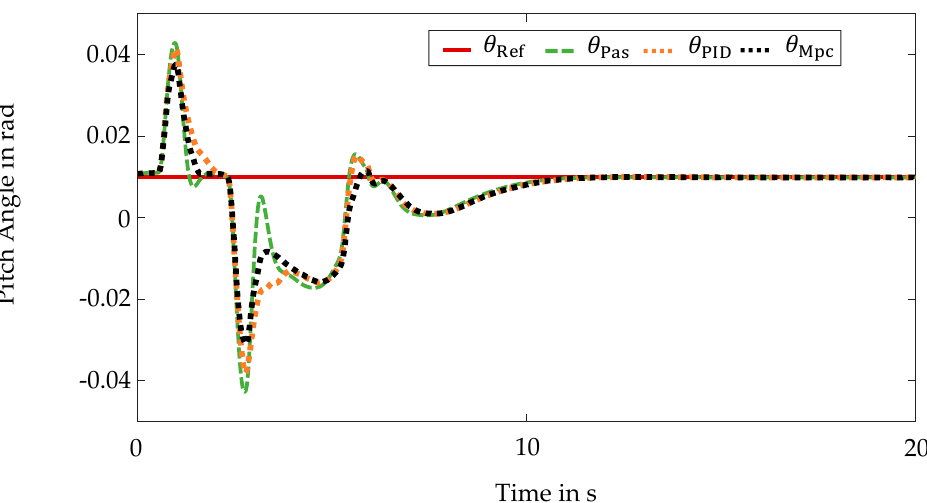
Figure 7. Control Quality Double Lane Change–Pitch Behavior–Pitch Angle Curves.